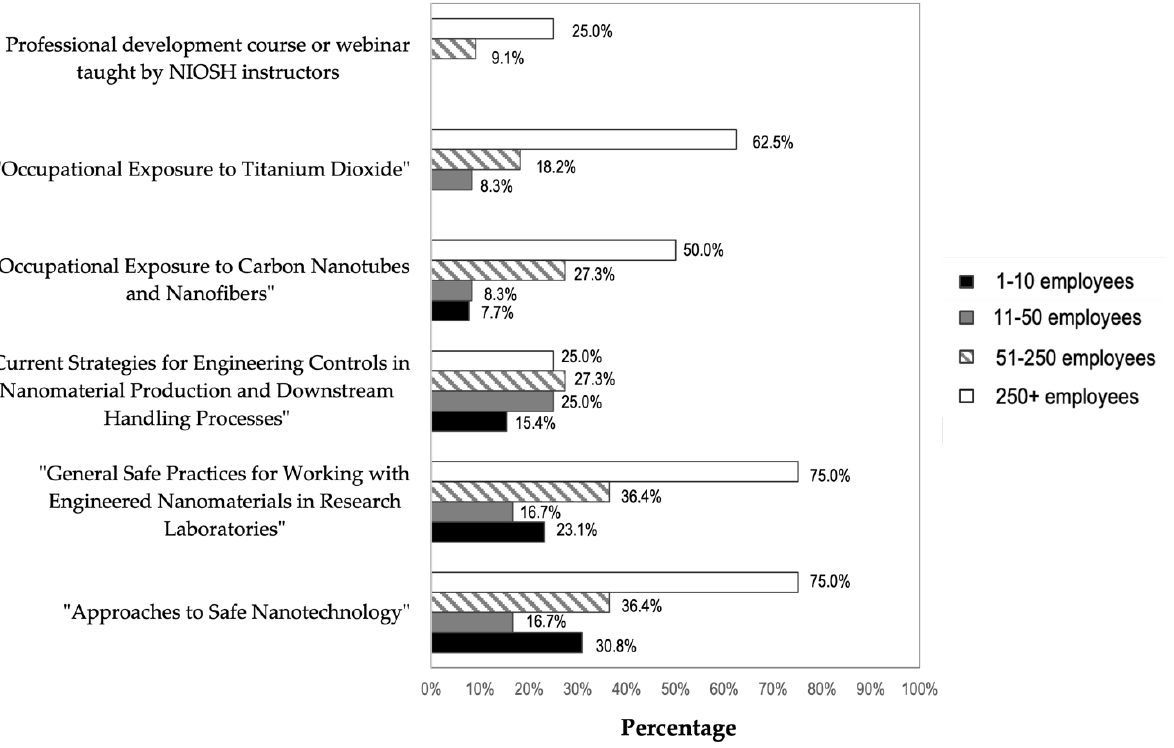
Figure 5. NIOSH Resources Used by Company Size. Note: multiple responses allowed. Percentages in each column are based on the number of respondents in each category: 1 – 10 employees = 13 respondents; 11 – 50 employees = 12 respondents; 51 – 250 employees = 11 respondents; 250+ employees = 8 respondents.